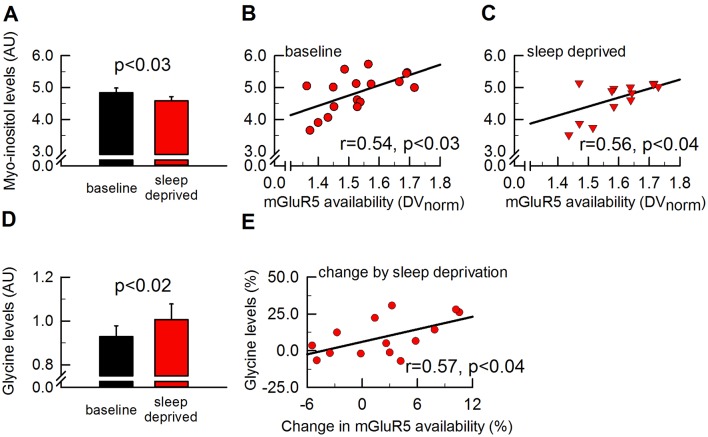
Myo-inositiol and glycine levels are altered by sleep deprivation in parallel with mGluR5 availability.To assess cerebral metabolic changes that are altered in synchrony with global mGluR5 availability by sleep deprivation, 17 metabolites measured in the pgACC (see Figure 2 for further details) were investigated. Whereas neither glutamate, glutamine nor GABA were found to be altered by sleep loss, myo-inositol was decreased by ~5.5% by sleep deprivation (A) and significantly associated with global mGluR5 availability in both sleep conditions (B-C). Glycine was enhanced by ~8.5% by sleep deprivation (D) and the increase in glycine positively correlated with the increase in global mGluR5 availability (E). Error bars represent standard errors of the mean (SEM), p-values indicate paired two-tailed Student’s t-tests and Spearman rank correlation coefficients (r).